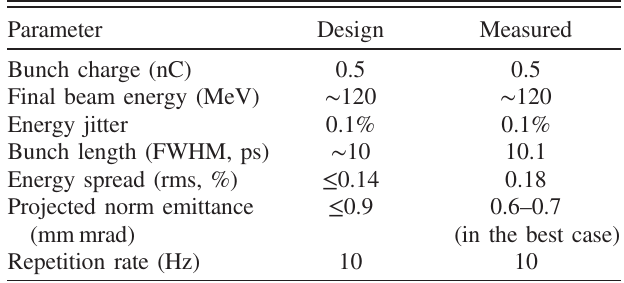
Table I. Initial commissioning with the first electron beam TABLE I. Main design and typically measured parameters of the photoinjector in